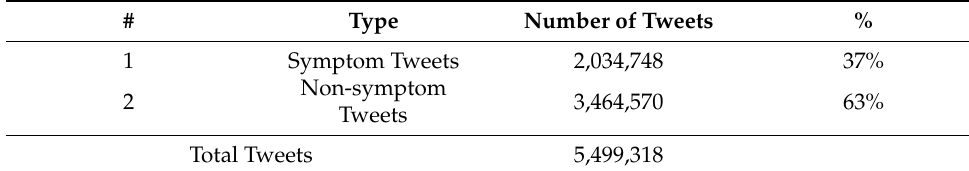
Table 9. Symptom and non-symptom tweets distribution.